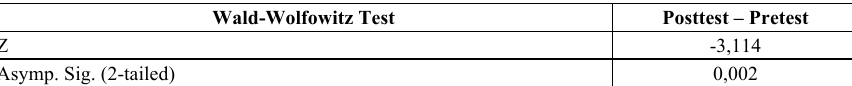
Table 9. The result of effectiveness testing of the computer-based drilling learning model